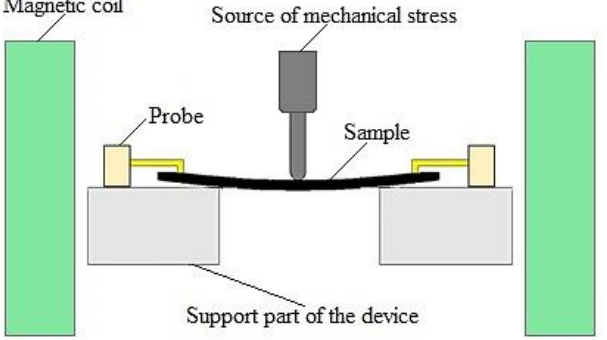
Figure 2. Schematic representation of the main setup unit.